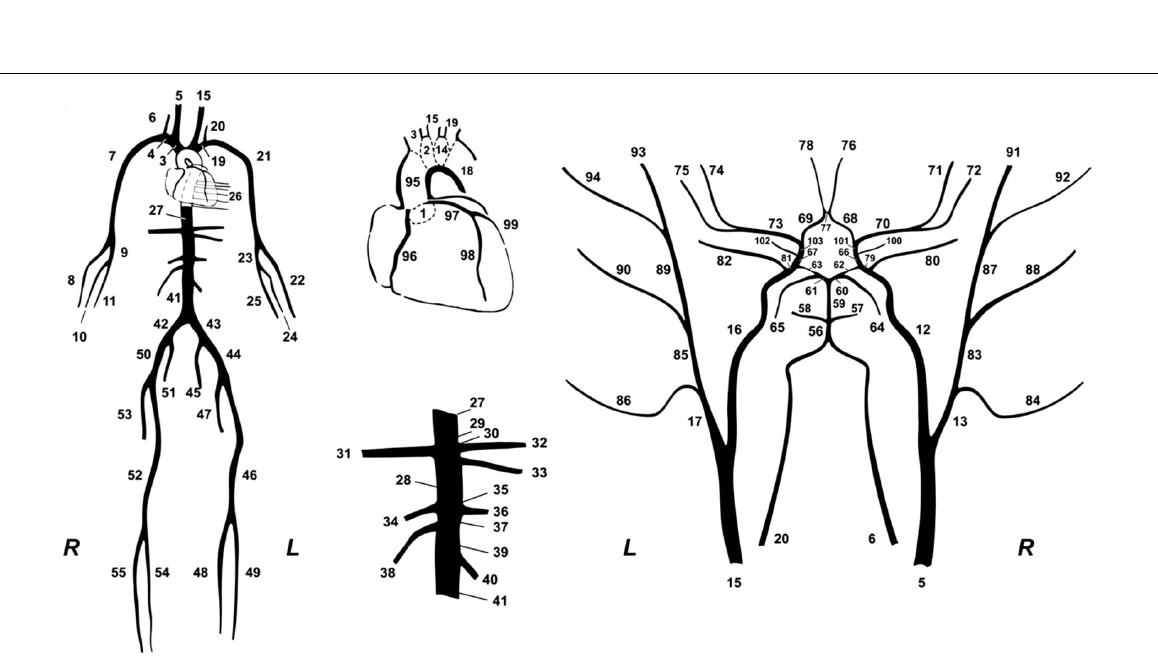
Frontiers in Bioengineering and Biotechnology |